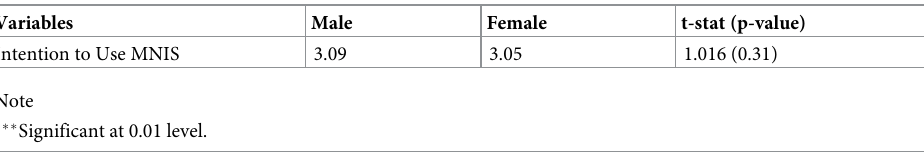
Table 2. Mean scores for intention to use MNIS.